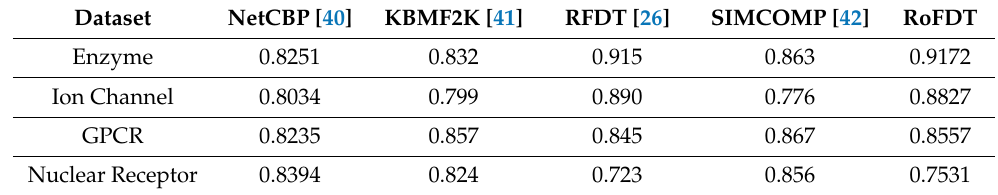
Table 7. Comparison with previous excellent models on the four gold standard dataset.